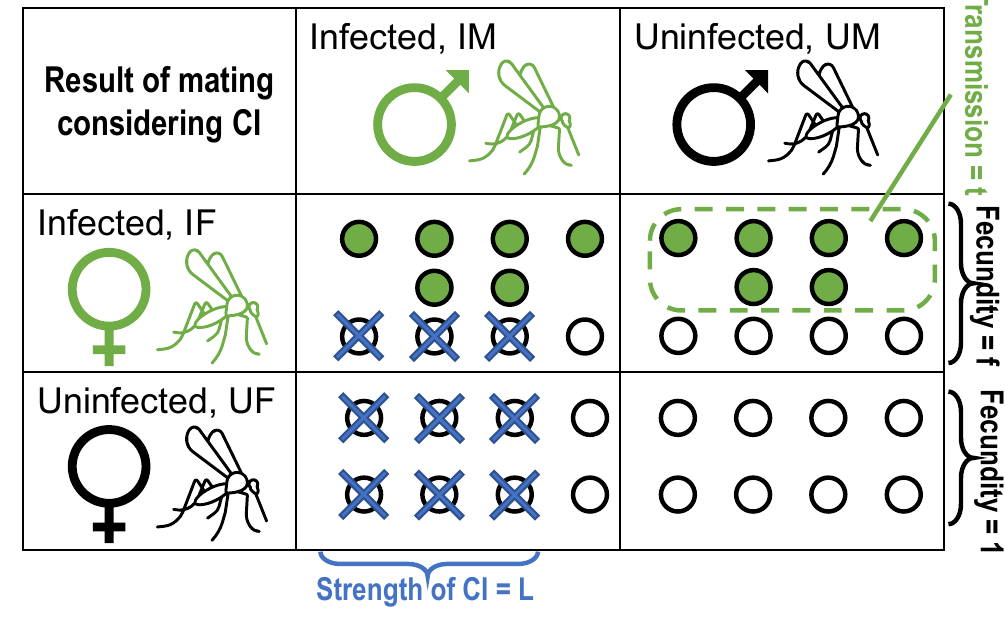
Figure 1. Mating results and key parameters of reproduction when insect population contains Wolbachia infected individuals. When an infected male (IM) fertilizes eggs, the Wolbachia -modified sperm leads to cytoplasmic incompatibility in all Wolbachia -free eggs, regardless of the infection status of their mother (IF, UF). Uninfected males (UM) fertilize all eggs successfully. Note that in the diplodiploid case, the incompatible eggs (that die) could have developed as either males or females. In haplodiploids, where fertilization produces females, the incompatible eggs would all be originally female. In the female-killing type they simply die, while in the masculinization type they develop as males